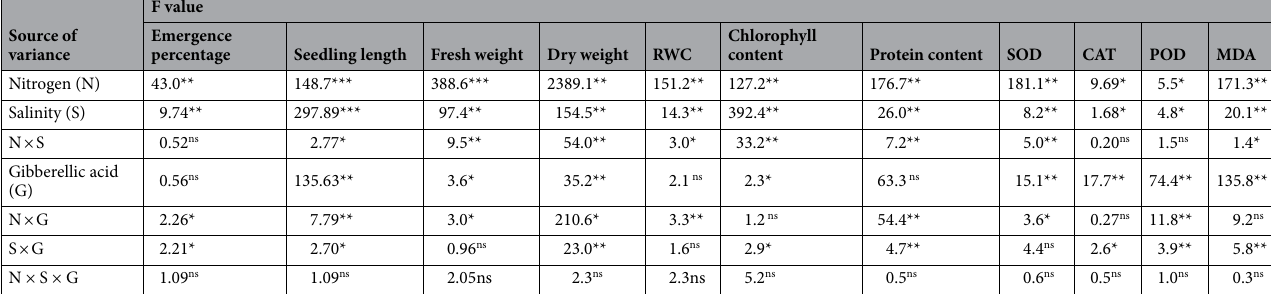
Table 1. Summary of analysis of variance (ANOVA table) for emergence percentage, seedling length, fresh weight, dry weight, Chlorophyll content (SPAD reding), relative water content (RWC), protein content, superoxide dismutase (SOD), catalase (CAT), peroxide (POD), and malondialdehyde (MDA) of sorghum seedlings as effected by salinity, nitrogen and gibberellic acid and their interactions. ns not significant. *Significant at the 0.05 probability level. **Significant at the 0.01 probability level. ***Significant at the 0.001 probability